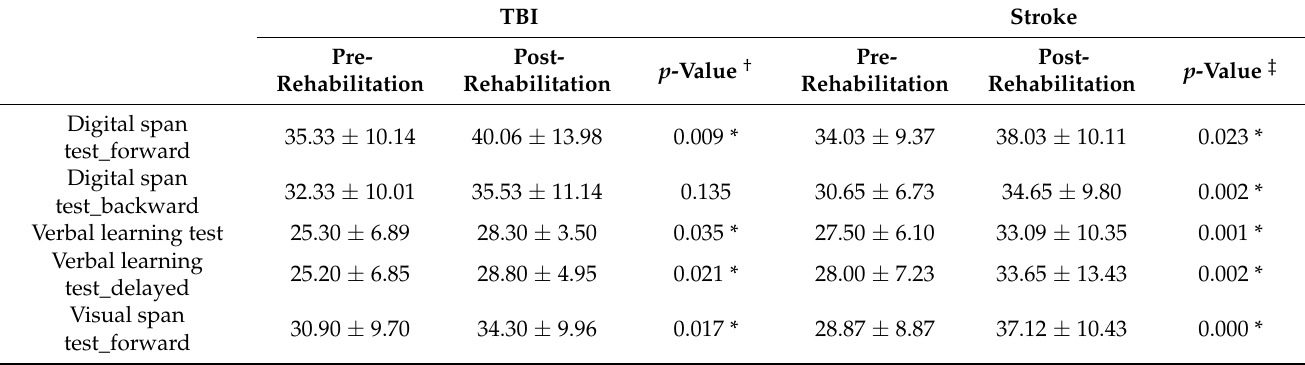
Table 2. Analyses of the differences between pre- and post-cognitive rehabilitation in the TBI and stroke